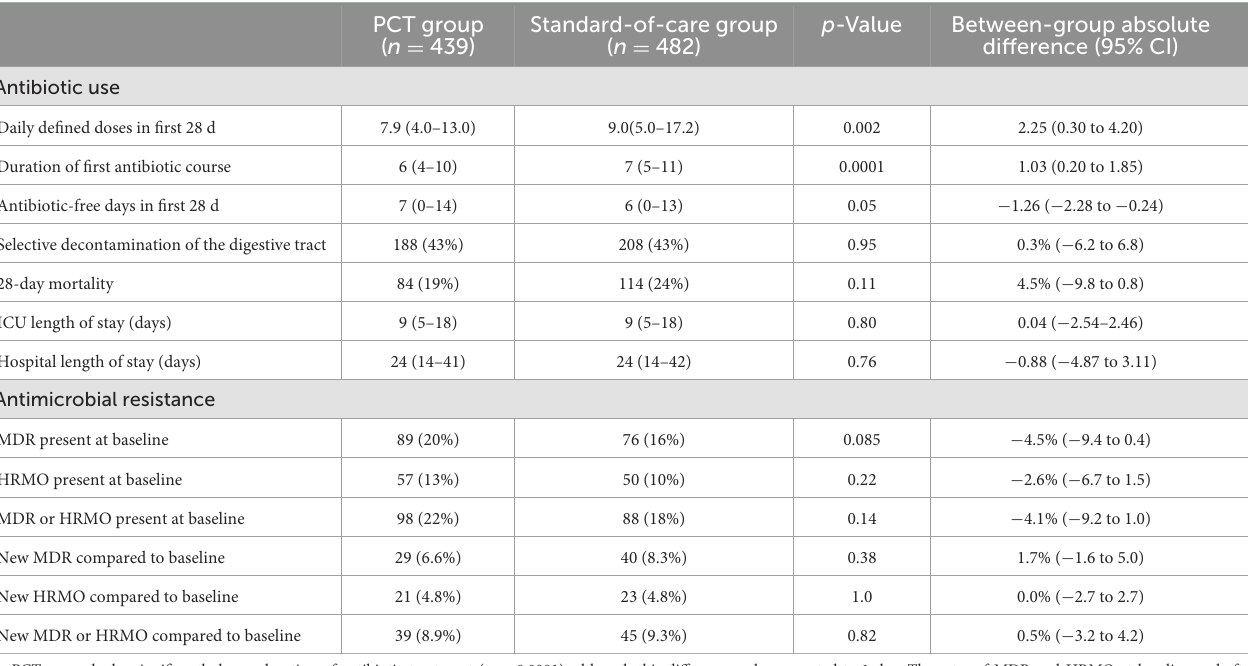
PCT group Standard-of-care group ( n = 439) ( n = 482)